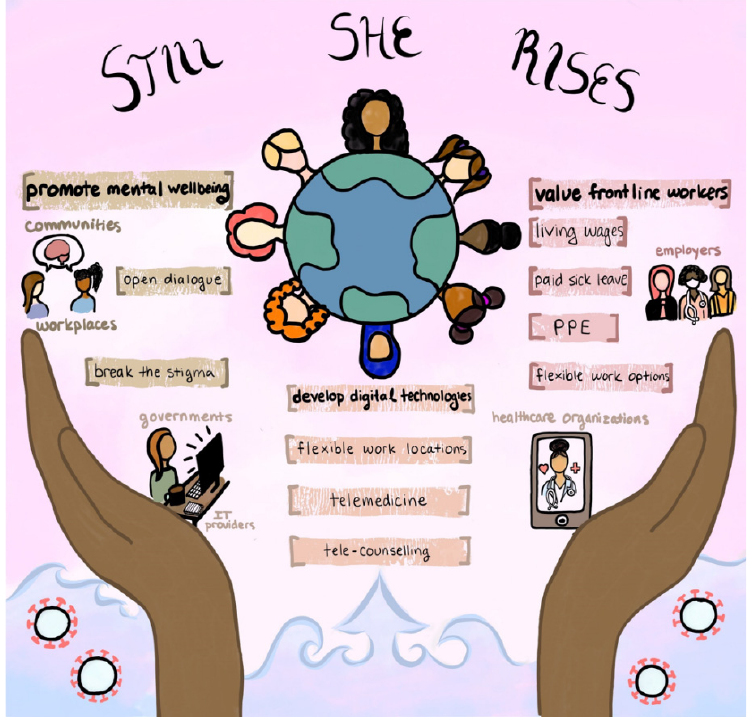
Figure 2. Our women’s global health policy recommendations (Diagram by Jaya Kailley).